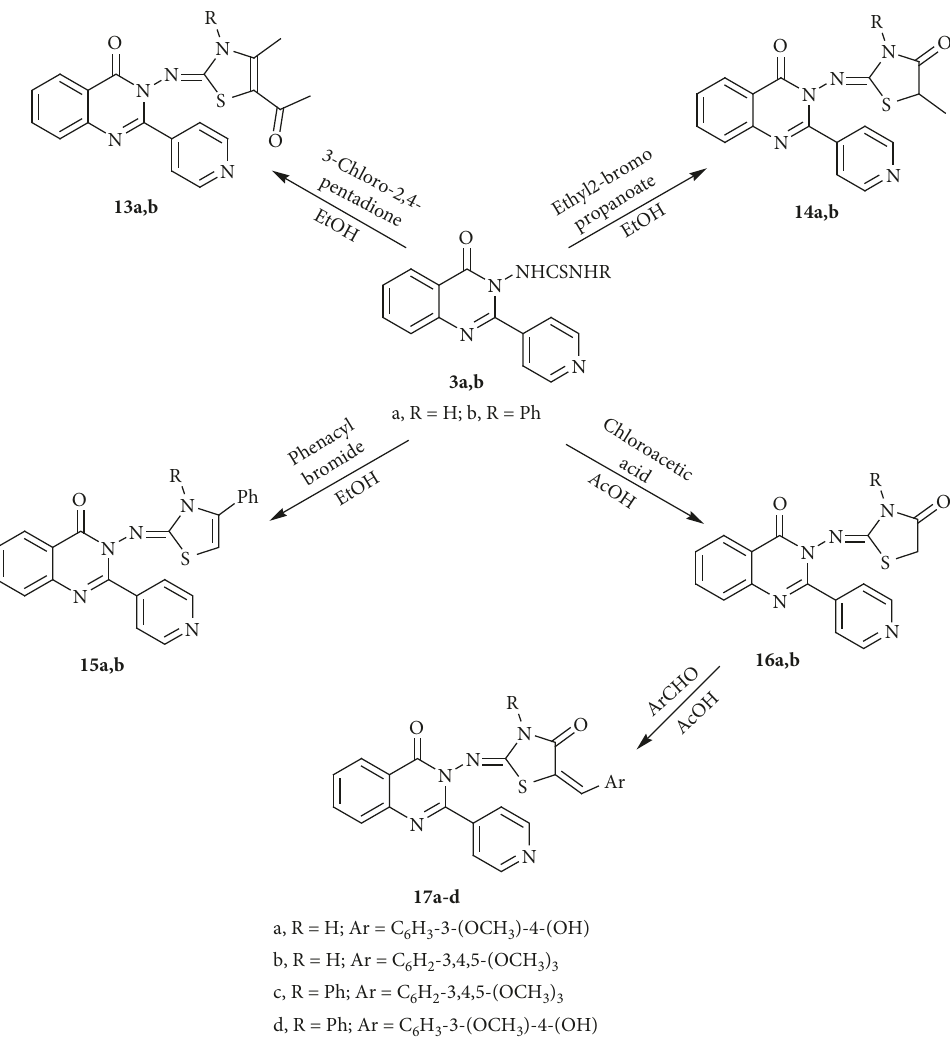
Scheme 4: Synthesis of compounds 13 – 17